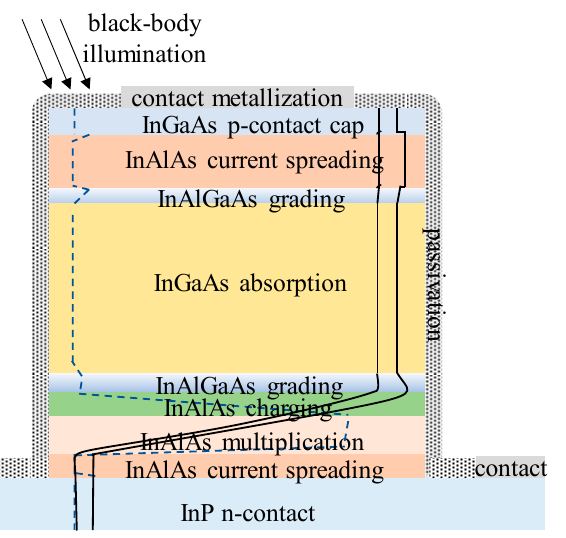
Figure 31. Schematic diagram of InGaAs/InAlAs SAGCM APDs with calculated band-edge profile